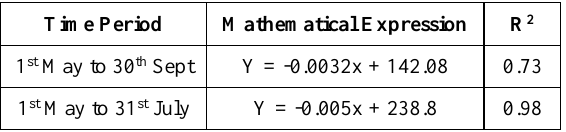
Table 2. Variation of SDC for different time periods in a snow melt season